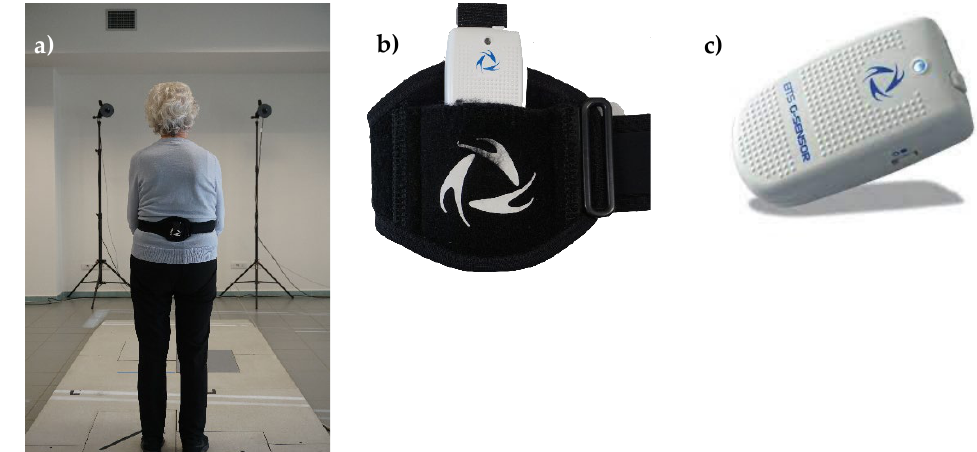
Figure 2. From left to right: ( a ) participant equipped with the IMU for the gait trials; ( b ) detail of the IMU positioning inside the semi-elastic belt; ( c ) the BTS G-Sensor IMU used for the experimental tests.